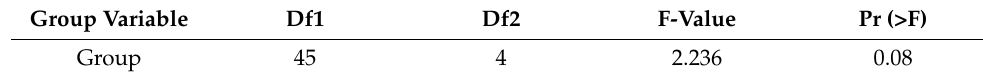
Table 4. Levene’s test summary. Defining the homogeneity of variances. Group